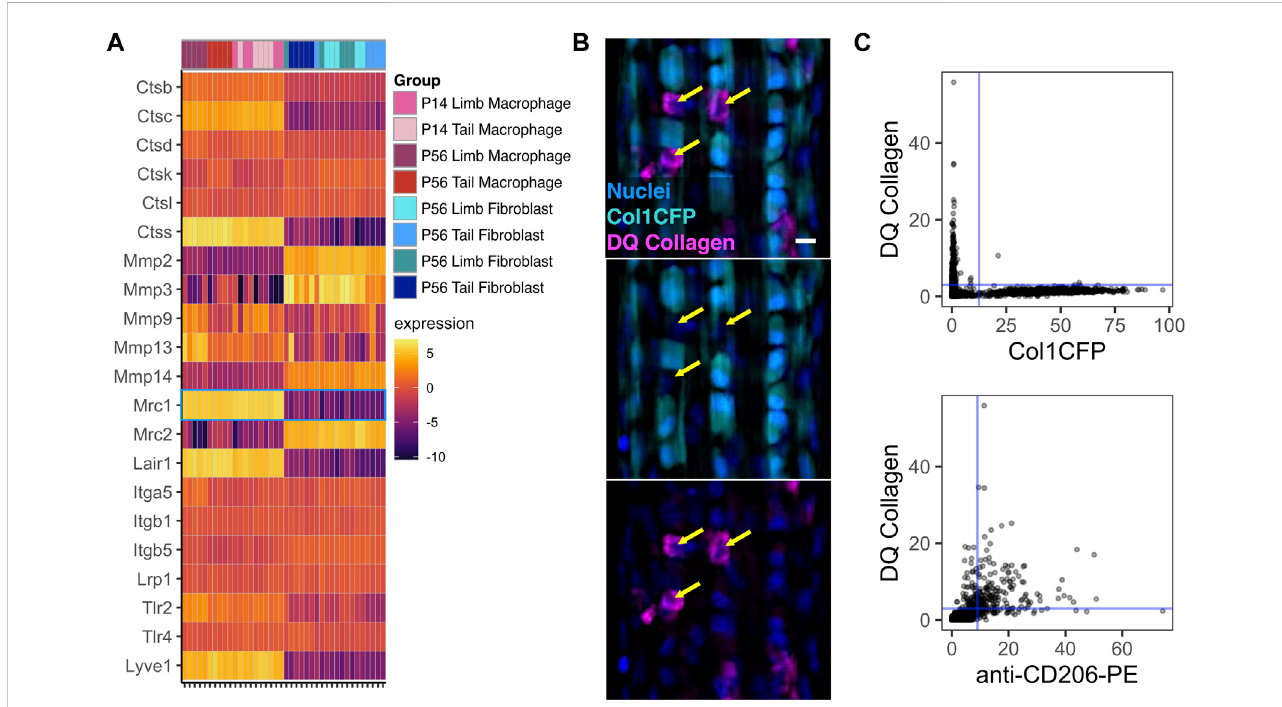
FIGURE 7 Tendon resident macrophages express ECM remodeling genes and internalize type I collagen (A) Heatmap of ECM-related genes. Mrc1 (CD206) is outlined in blue (B) Representative image of Col1CFP tail tendons cultured with DQ Type I Collagen conjugated with fl uorescein. Yellow arrows indicate Col1CFP − cells with internal DQ Collagen signal. Scale bar = 10 µm (C) Quanti fi cation of DQ Collagen vs Col1CFP signal intensity (top) and DQ Collagen vs. anti-CD206-PE signal intensity (bottom) in cells isolated from tail tendon